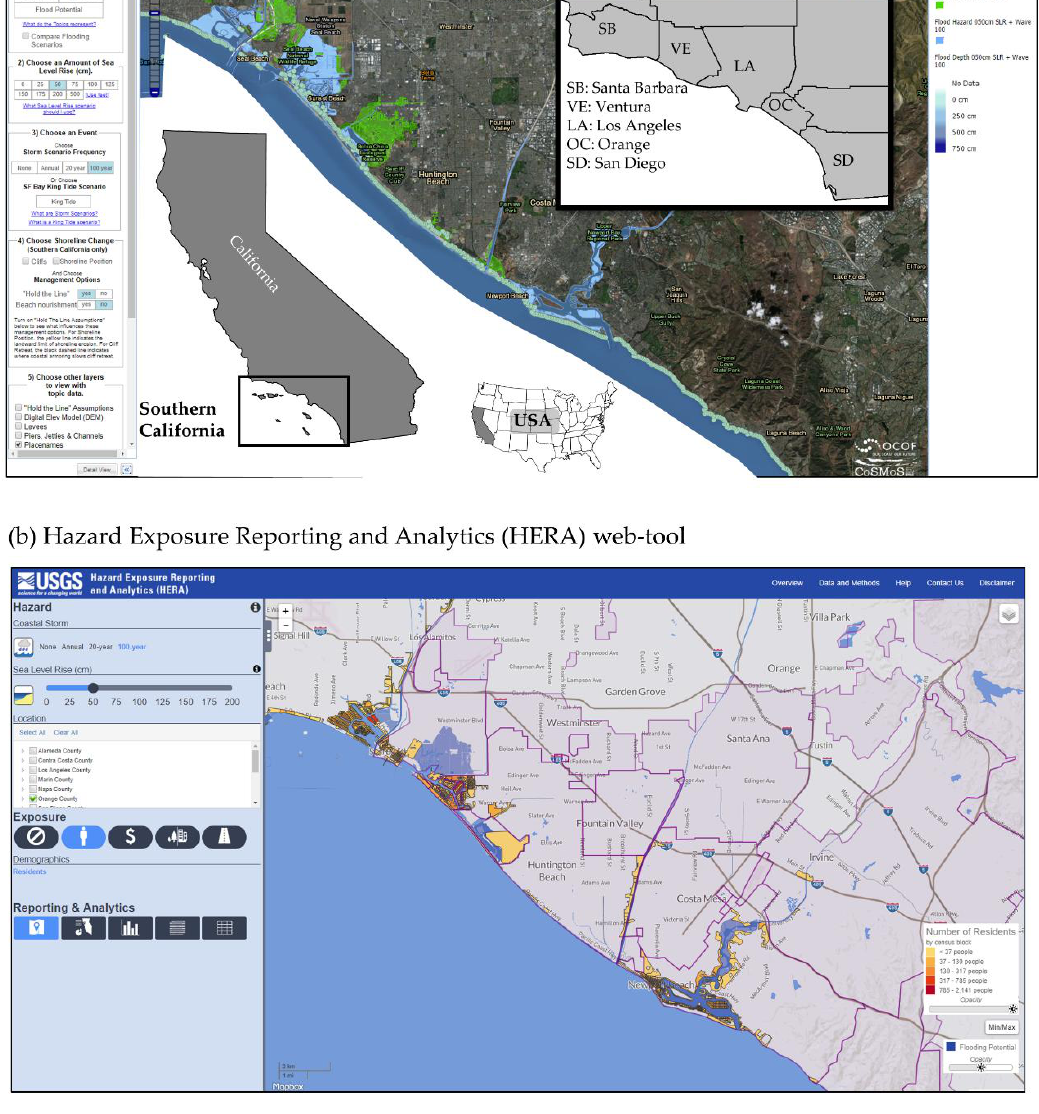
Figure 1. Web applications for visualization, synthesis, socio-economic analyses, and data download. ( a ) Screen-grab from the “Our Coast, Our Future” (OCOF) web tool showing coastal hazards associated with currents, wave heights, flood extents/depths, durations, and shoreline change for each of the modeled sea-level rise (SLR) and storm scenarios (www.ourcoastourfuture.org). Inset shows location of Southern California and the five coastal counties within the Southern California region; ( b ) Screen-grab from the Hazard Exposure and Analytics (HERA) web tool developed to aid in analysis of exposure and socio-economic statistics (https://www.usgs.gov/apps/hera/). Both applications contain a suite of tools and options for visualizing (maps and graphs) and synthesizing the model results. Example screen-grabs are for the Orange County (OC) area.